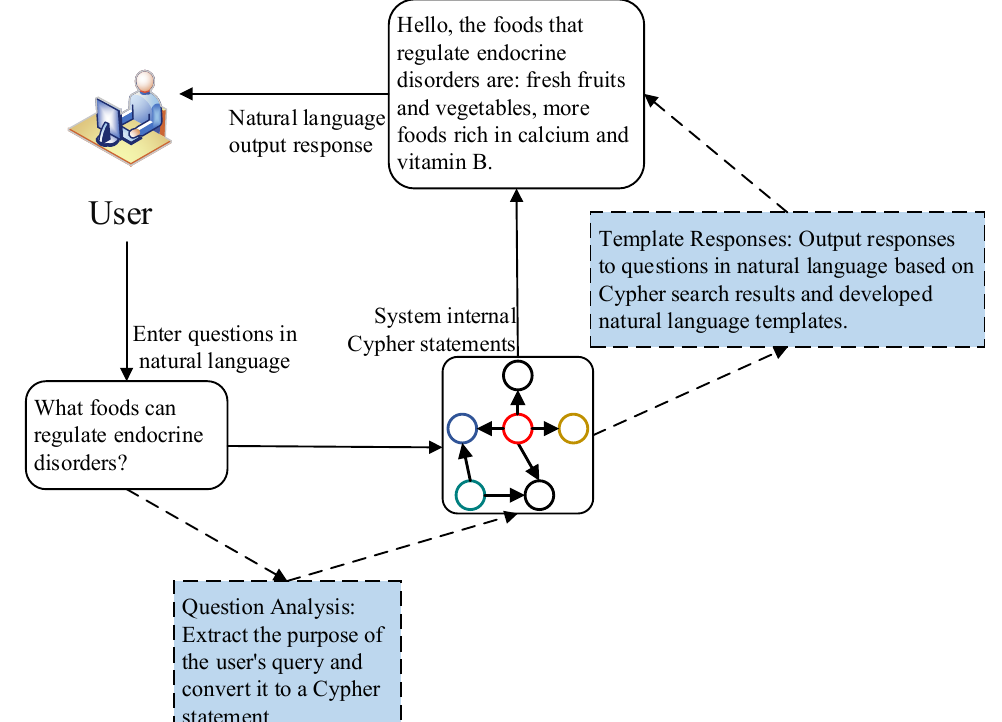
Figure 8. The implementation process of a medical intelligent question-answering system.